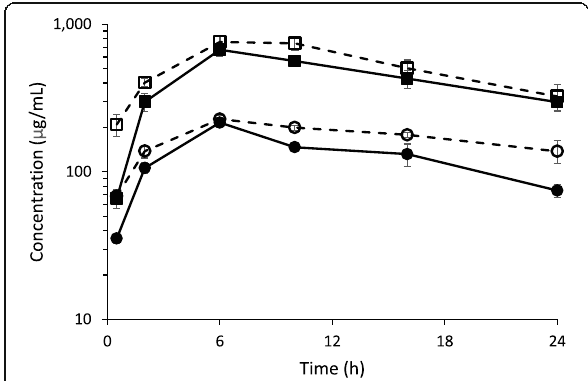
Fig. 8 Time courses of plasma levels of P-bi-TAT in monkeys on day 1 and day 7, n = 2 for female and n = 2 for males. Low dose 25 mg/kg body weight, high dose 82.5 mg/kg body weight. Error bars represent standard errors of the mean. Day 1, low dose: closed circles; day 7, low dose: open circles; day 1, high dose: closed squares; day 7, high dose: open squares